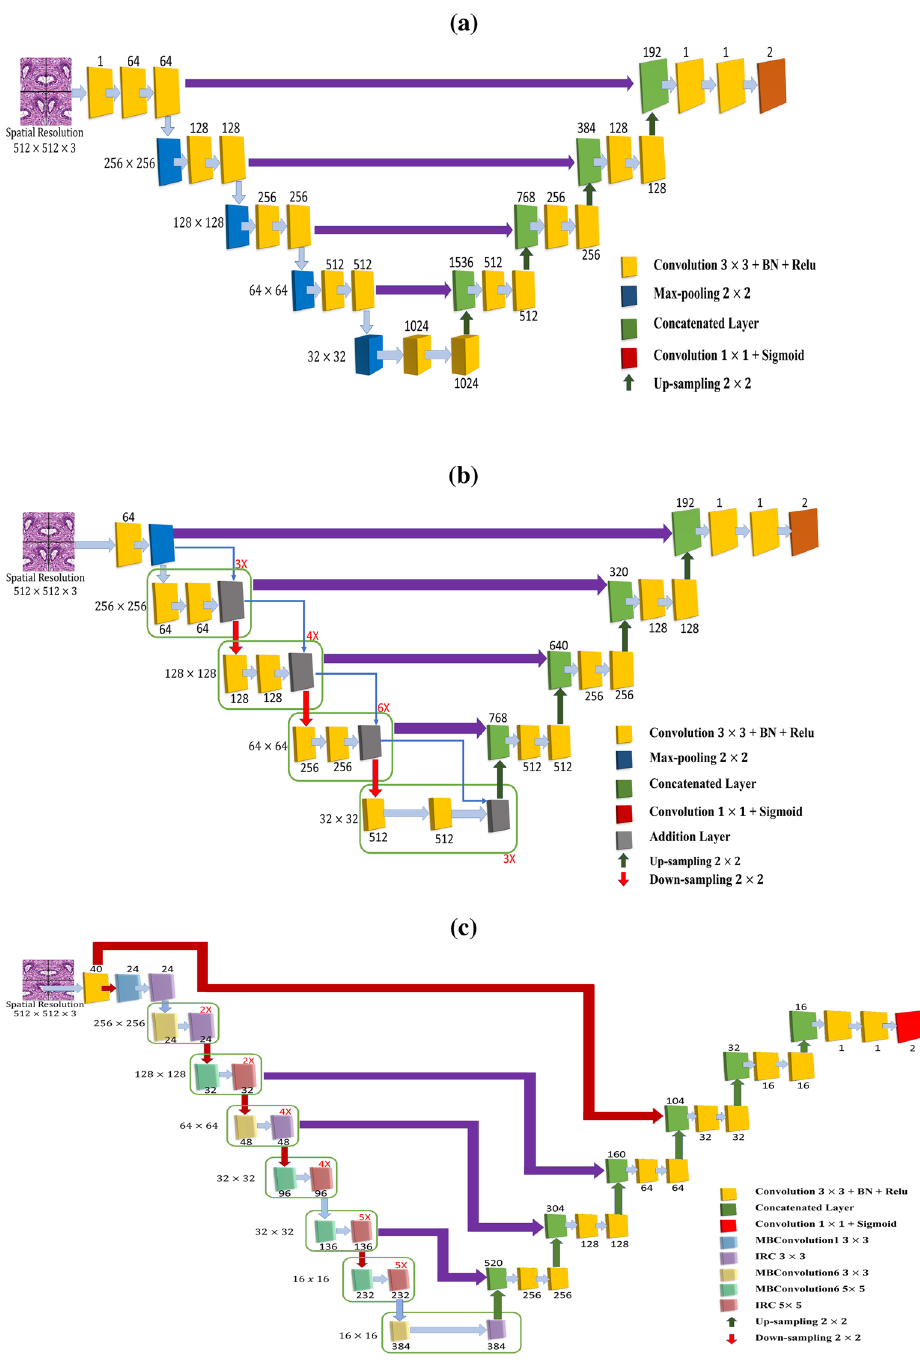
Figure 4. The encoder-decoder architecture of the deep learning models for tubule segmentation. ( a ) Original U-Net, ( b ) ResNet34-U-Net, and ( c )